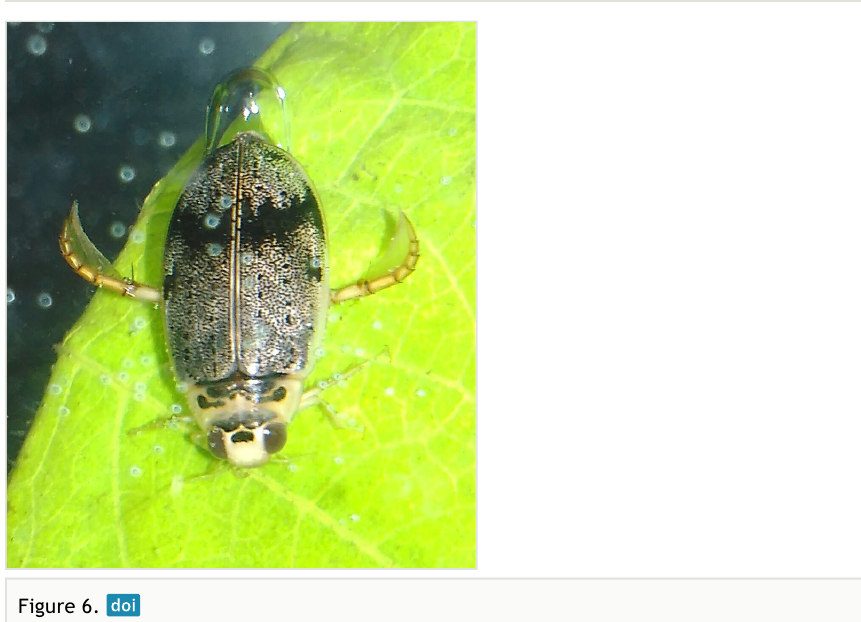
Figure 5. Eretes griseus , HP image from BALI_NS_2016_19 (background: Hydaticus bipunctatus conjungens ).